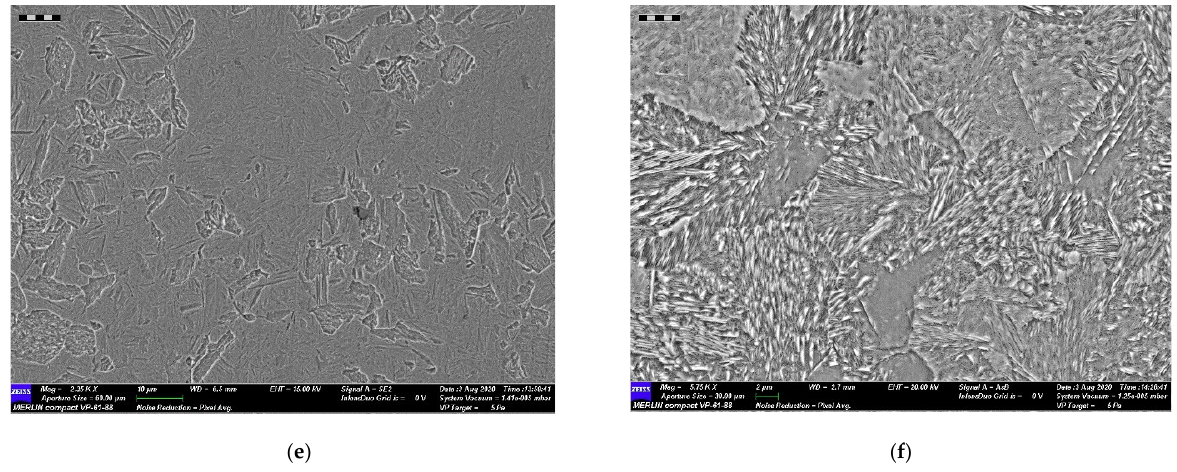
Figure 10. 52CrMoV4 SEM images of the microstructure cooled at ( a ) 100 °C/s, ( b ) 30 °C/s, ( c ) 20 °C/s, ( d ) 10 °C/s, ( e ) 1 °C/s, and ( f ) 0.1 °C/s.